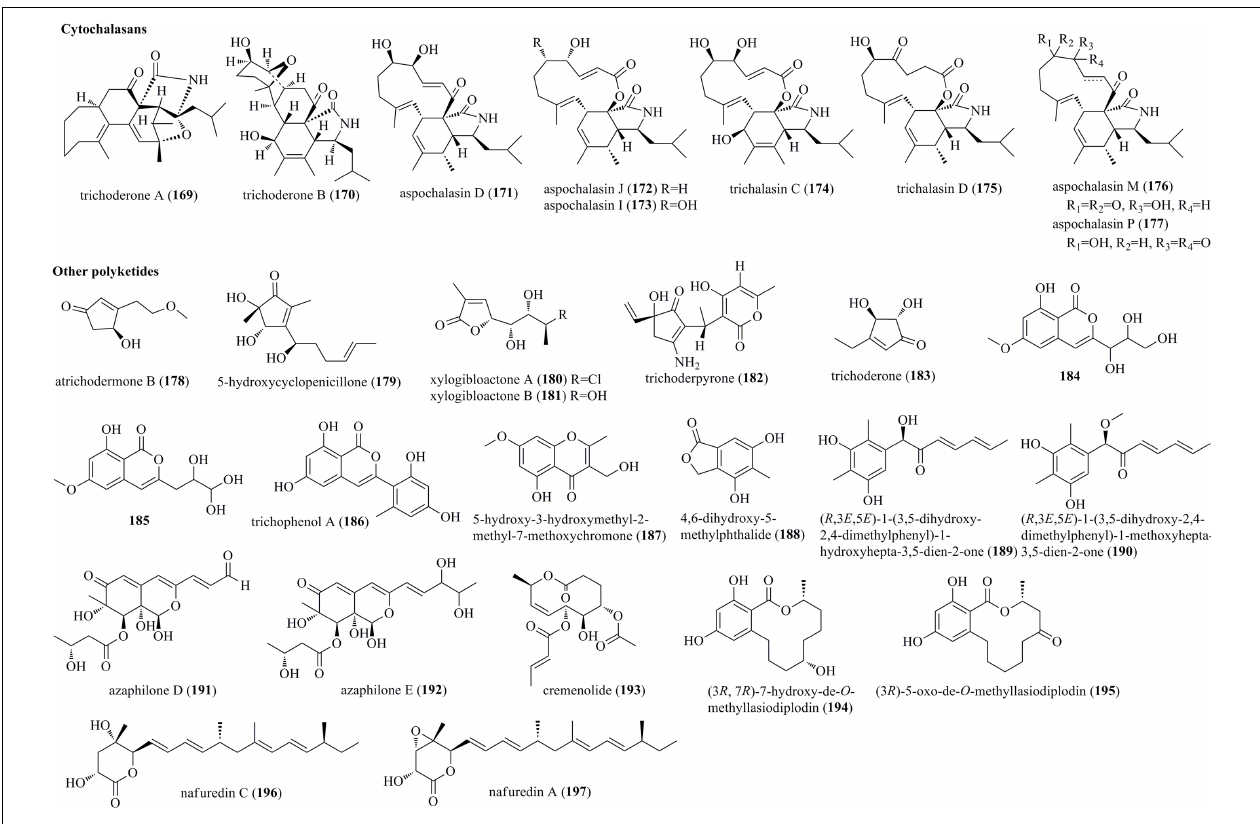
FIGURE 9 | Cytochalasans and other polyketides produced by Trichoderma species ( 169–197